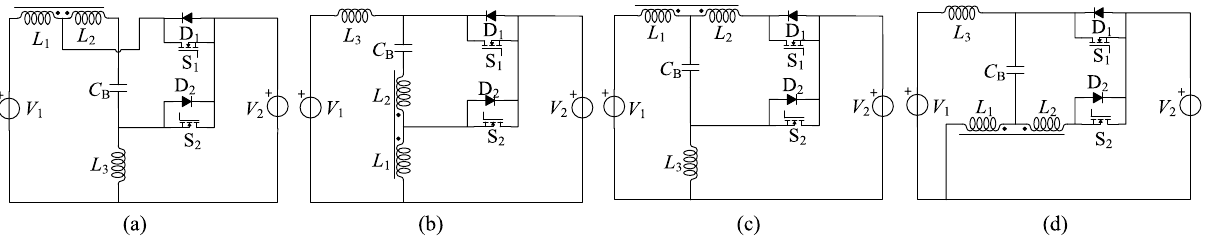
Figure 3. Bidirectional high-gain Cuk circuits are formed by the reverse-direction coupling, ( a ) S 1 -tap, ( b ) S 2 - tap, ( c ) C B -tap 1, ( d ) C B -tap 2.